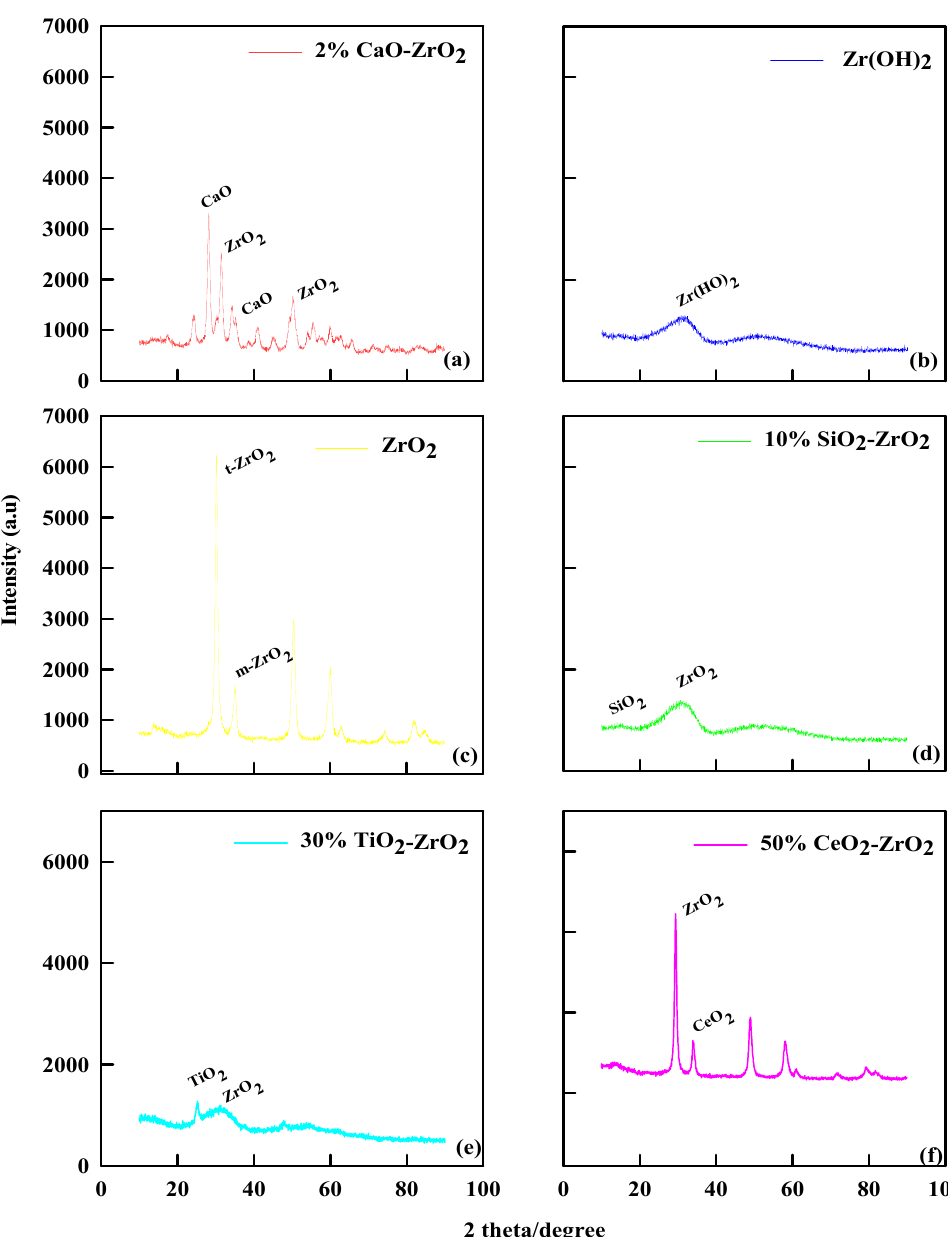
Figure 1. XRD pattern of ( a ) 2% CaO-ZrO 2 , ( b ) Zr(OH) 2 , ( c ) ZrO 2 , ( d ) 10% SiO 2 -ZrO 2 , ( e ) 30% TiO 2 -ZrO 2 , and ( f ) 50% CeO 2 -ZrO 2 . The XRD pattern for 10% SiO 2 -ZrO 2 shows a similar trend to Zr(OH) 2 . The